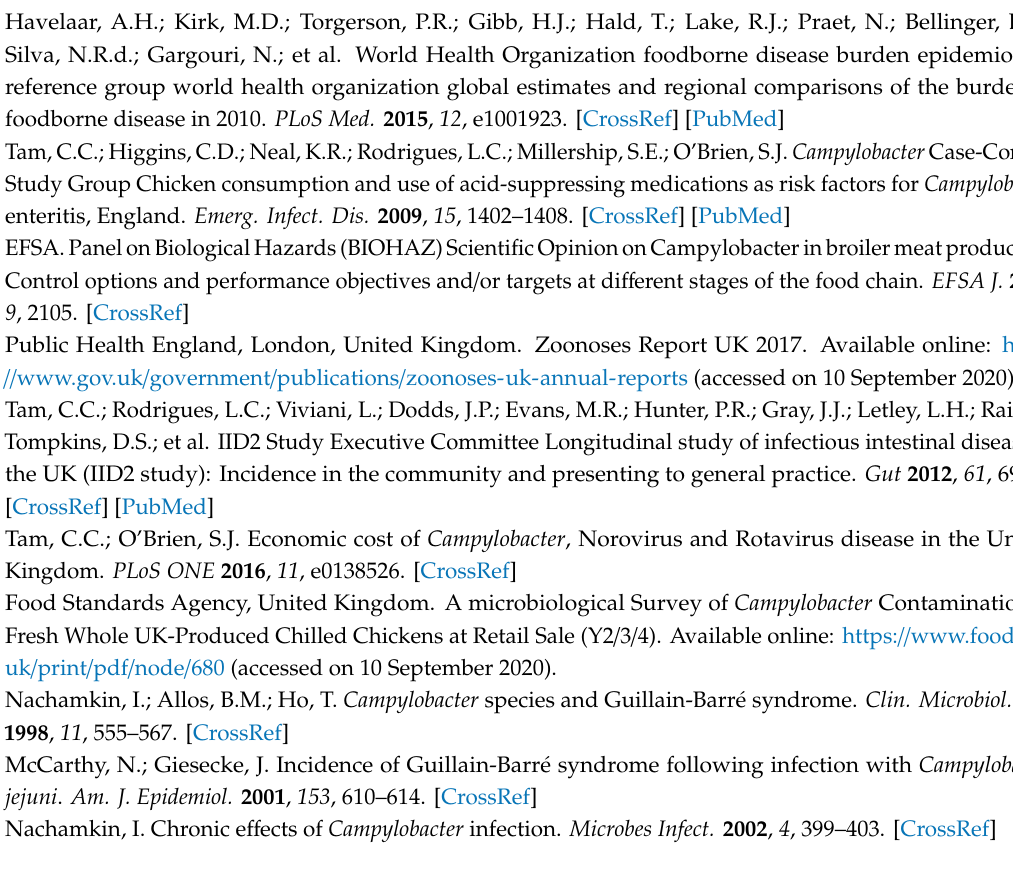
Figure S1: Schematic of constructs, Figure S2: Specificity of IgY